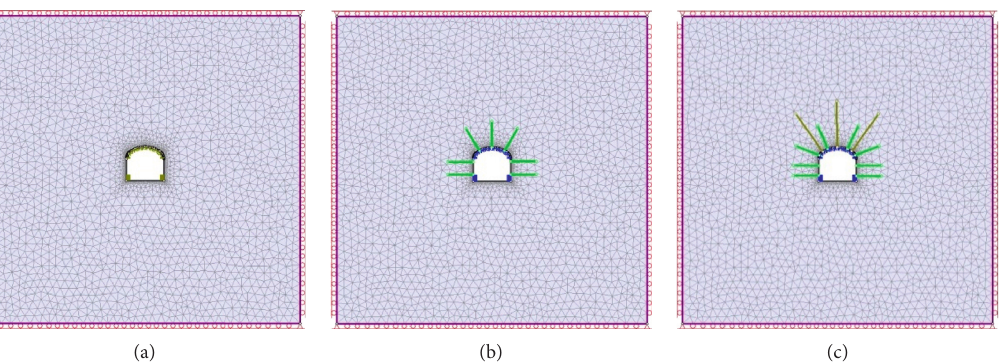
Figure 9: Numerical models using RS2 program for (a) sophisticated support, (b) support suggested by Q-system, and (c) the combination support